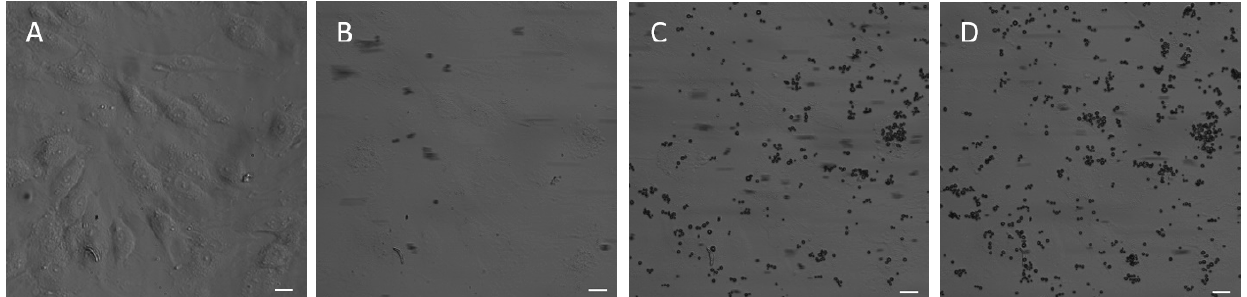
Figure 6. Optical microscopy real-time images (long distance objective 40×) of the PVA MBs carrier co-loaded with DOTA and cRGD (cRGD-PVA-DOTA MBs) targeted on the α V β 3 integrins of HUVEC cells (frame ( A ) a control image of the top side of the HUVEC-coated fluid channel), acquired under dynamic flow at 37 °C, shear rate 147 s − 1 (shear stress 1 dyne/cm 2 ); frame ( B ) the carrier was just injected in the channel (t = 0 min); frame ( C ) after 5 min of fluxing the carrier; frame ( D ) after 10 mi of fluxing (10 min). The control micrograph image shown in panel A was acquired in phase contrast mode to highlight the cell substrate; afterwards, on the same frame, the acquisition of the time-lapse sequence shown in panels ( B – D ) was set in bright field, focusing on the adhered MBs’ plane, to optimize the MBs’ visualization and processing by NIS-Elements software (AR Ver 5.30.02, Nikon). Scale bar: 20 μ m. Upon washing the channel with PBS solution mixed with 10% of bovine serum, the carrier remains adhered onto the HUVEC cells substrate.